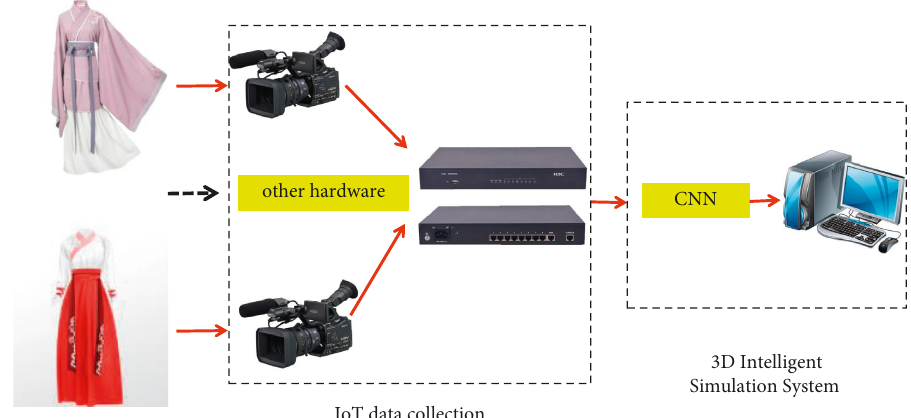
Figure 1: The design of Hanfu 3D simulation system based on IoT technology.